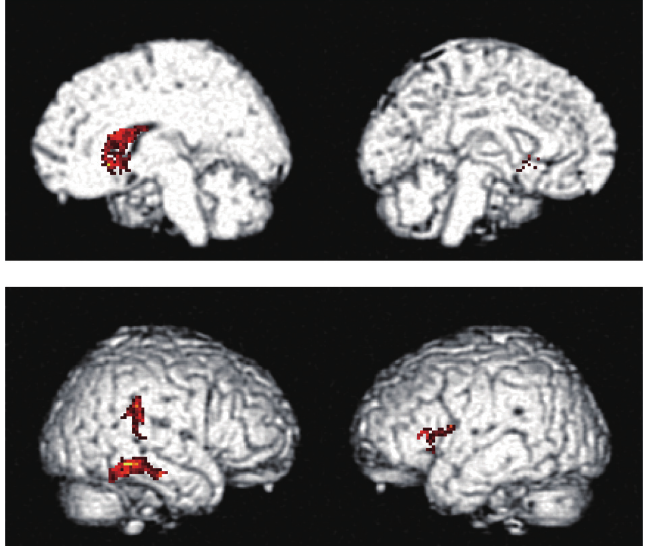
Fig. 1. Areas of atrophy that are signi fi cantly related to caregiver ratings of bvFTD patients on the Apathy Evaluation